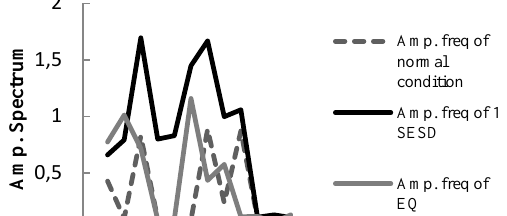
Fig. 9. EQs that occurred in Greece from January to April 2008 with Fig.9. EQs occurred in Greece from January to April 2008 with magnitudes greater than Ms=5R (Thanassoulas magnitudes greater than M s = 5R (Thanassoulas et al., 2008). et.al., 2008)